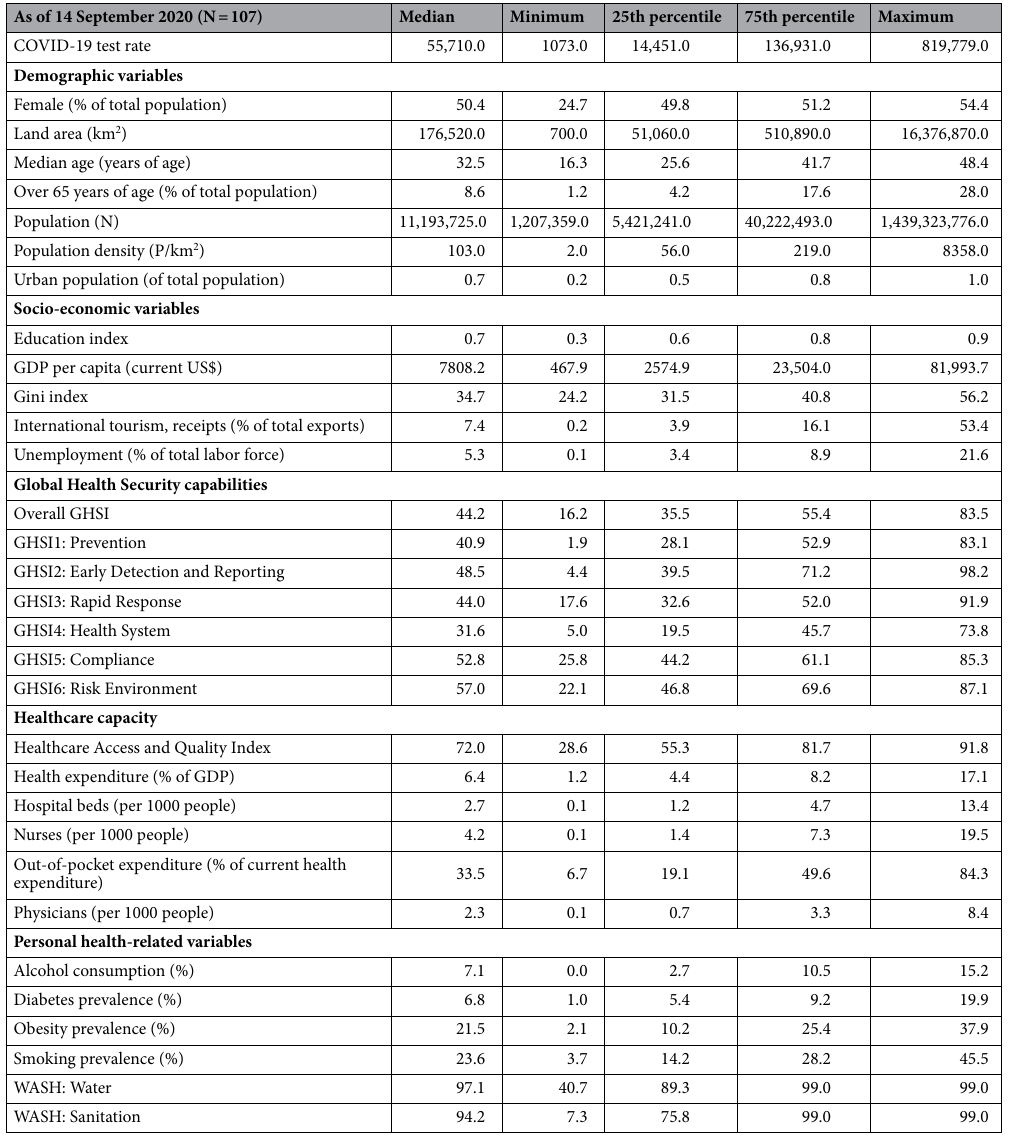
Table 2. Characteristics of total selected countries. COVID-19 test rate number of COVID-19 tests performed per one million population, GDP Gross Domestic Product, GHSI Global health Security Index, WASH: Water index that assesses the safety and accessibility to water, WASH: Sanitation index that assesses the facility sanitation.